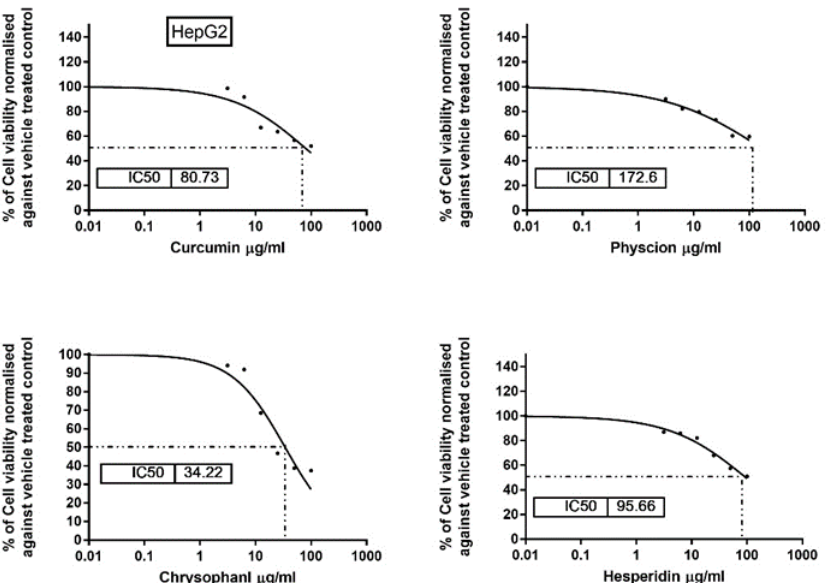
Figure 2. Cytotoxic effect of the isolated compounds on HepG2. Cells were treated with various concentrations of compounds (100, 50, 25, 12.5, and 3.25 µg/mL) for 24 h and the cell viability was determined by MTT assay. The results are expressed as percentage of cell growth relative to negative control (vehicle treated) cells.